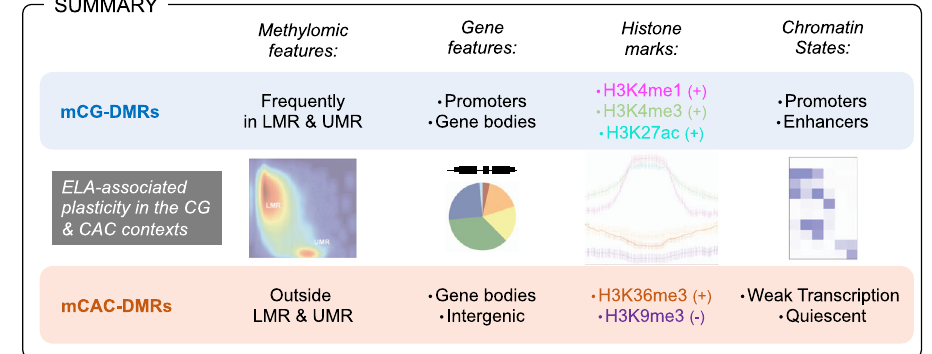
Fig. 8 Methylomic adaptations associated with early-life adversity (ELA) in the CG and CAC contexts show multiple distinct properties. The fi gure depicts a summary of methylomic and gene features, as well as histone marks and chromatin states that characterize genomic sites where differentially methylated regions (DMR) were identi fi ed as a function of ELA in the CG and CAC contexts. See main text for details. LMR lowly methylated regions, UMR unmethylated regions, + and − indicate enrichment and depletion in the corresponding histone mark, for each DMR